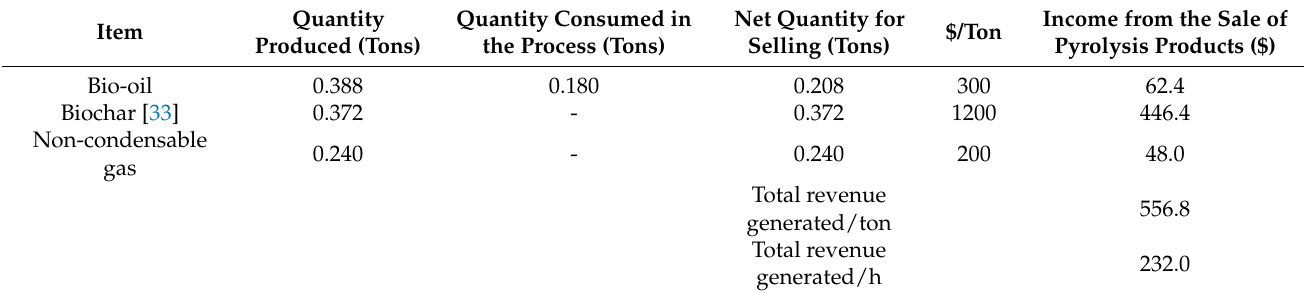
Table 8. Revenue generation from pyrolysis of one ton of date palm